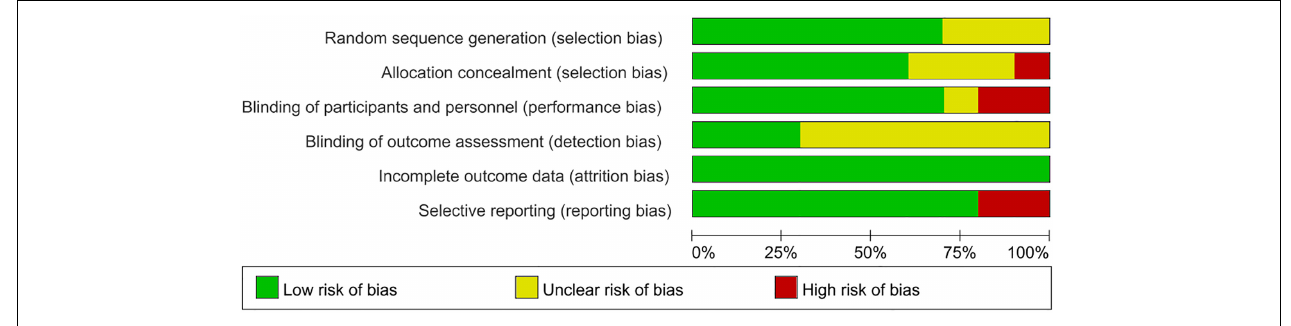
FIGURE 3 | Risk of bias graph review authors judgments about each risk of bias item presented as percentages across various study designs.